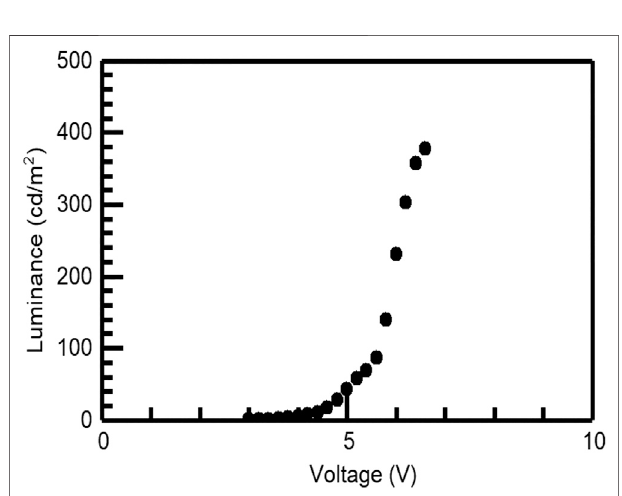
FIGURE 7 | Luminance – voltage curve of MA 0.6 FA 0.4 PbI 2.8 Br 0.2 perovskite solar cells operating in the light-emitting mode.